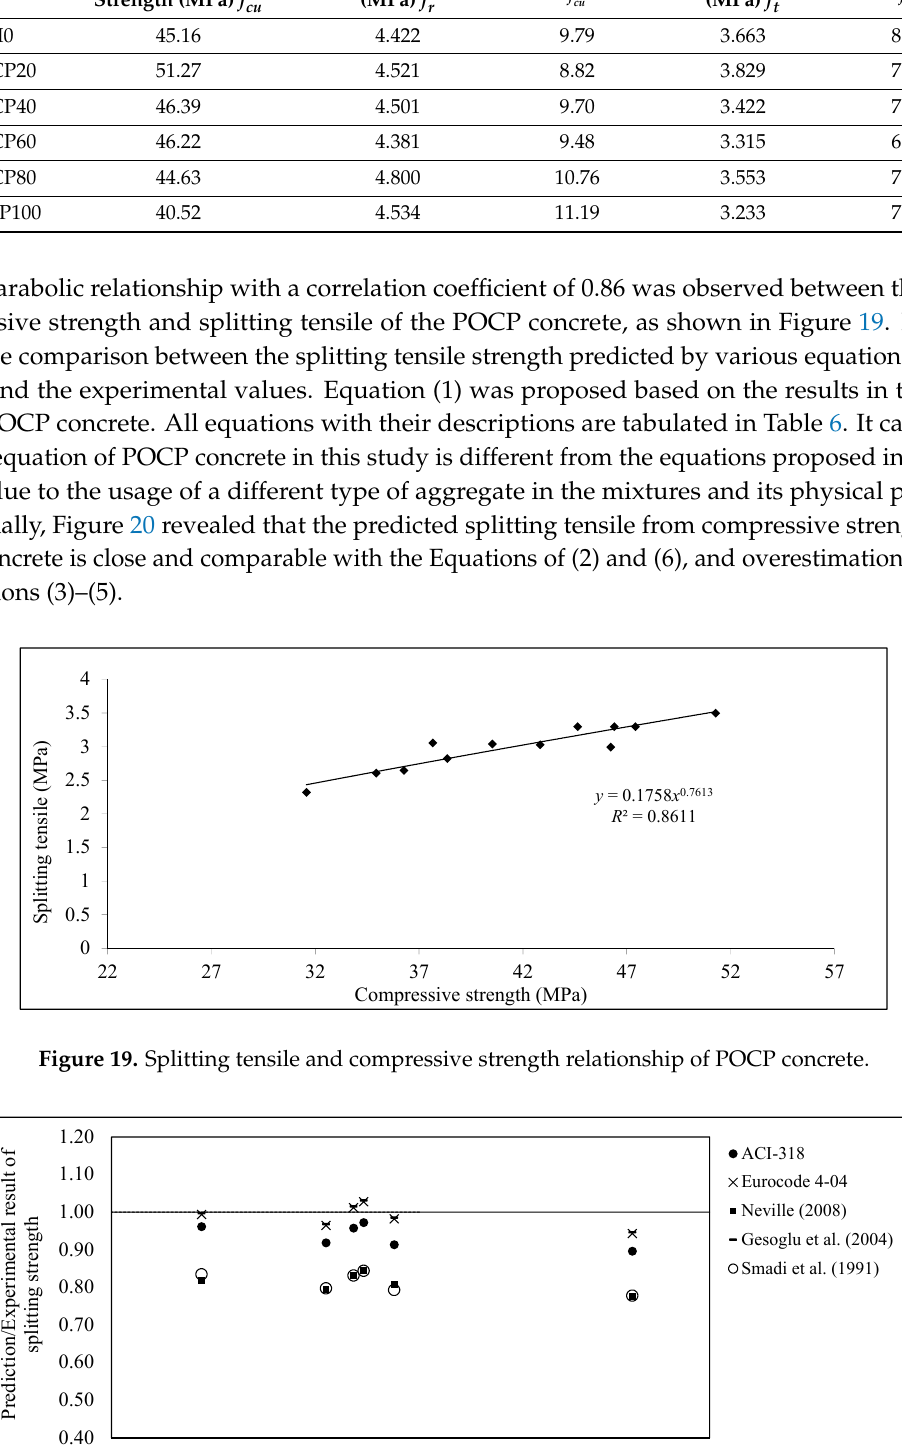
Table 5. Flexure, splitting and compressive strength relationship at 28 days.